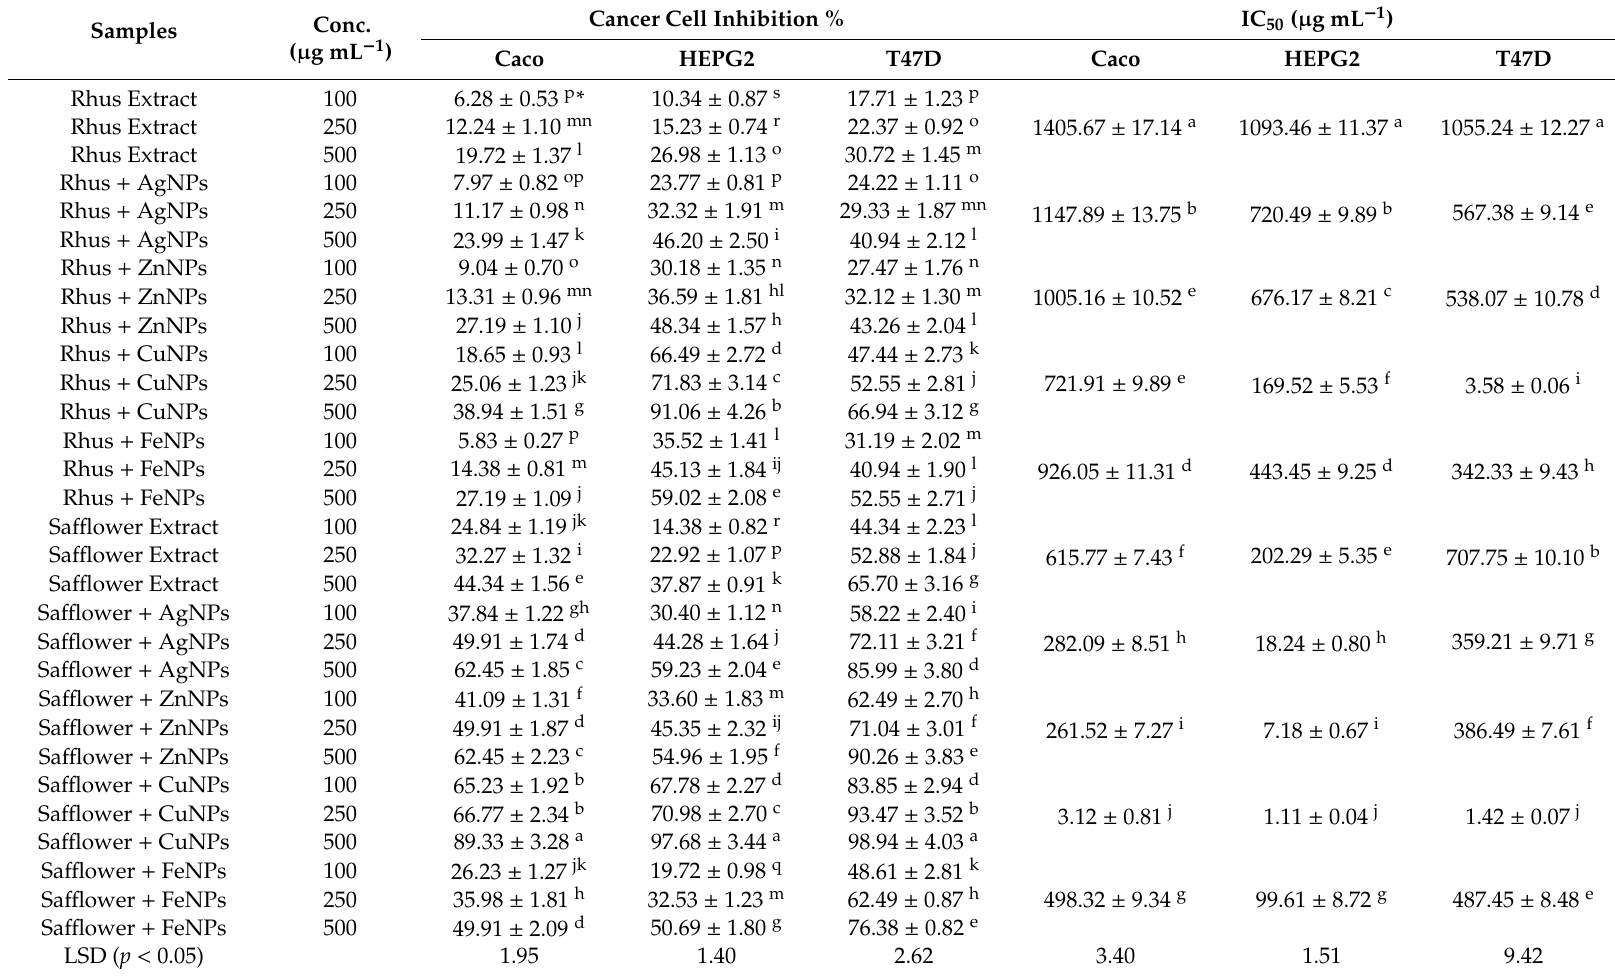
Table 2. Anticancer activities of rhus and sa ffl ower extracts and their nanoparticles against Caco-2, HEPG2 and T47D cell lines.